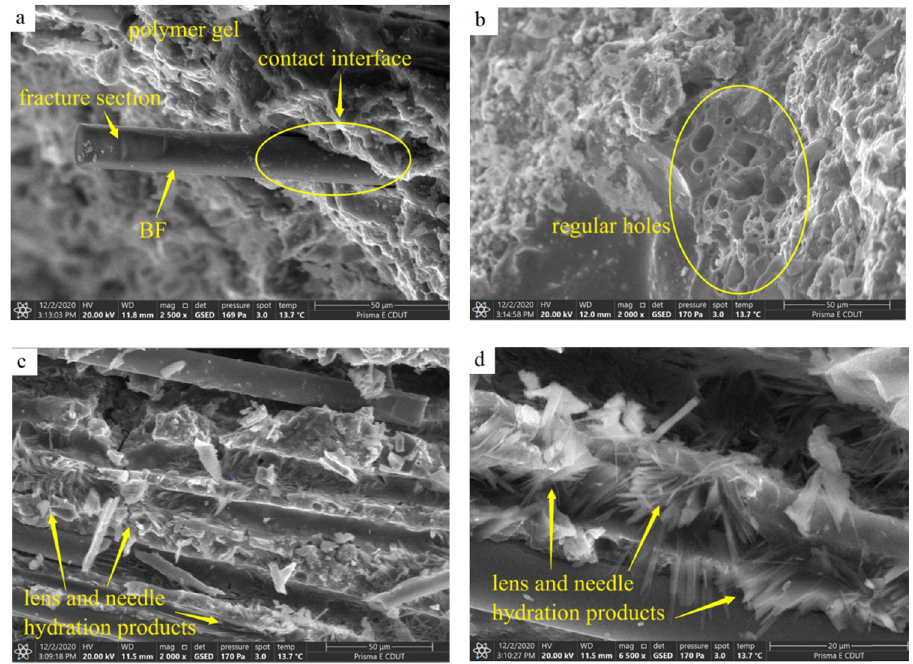
Figure 13: BFCGGPC - 0.5. ( a ) mag2500 × BF contact interface ( b ) mag2000 × regular holes ( c ) mag2000 × lens and needle hydration products ( d ) mag6500 × lens and needle hydration